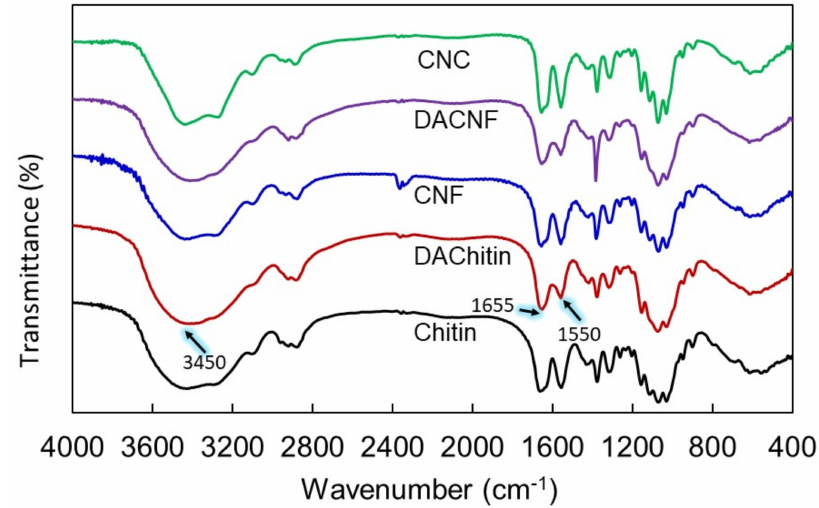
Figure 3. FTIR spectra of chitin, deacetylated chitin (DACTN), chitin nanofibers (CNF), deacetylated chitin nanofibers (DACNF), and chitin nanocrystals